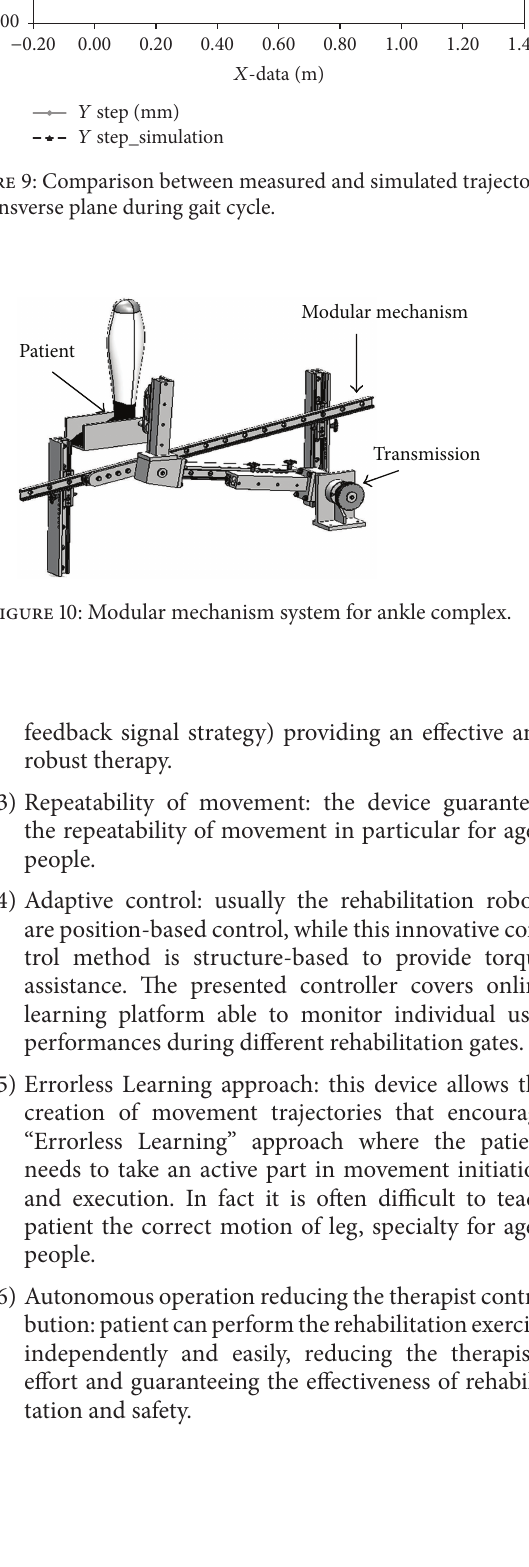
Figure 10: Modular mechanism system for ankle complex.